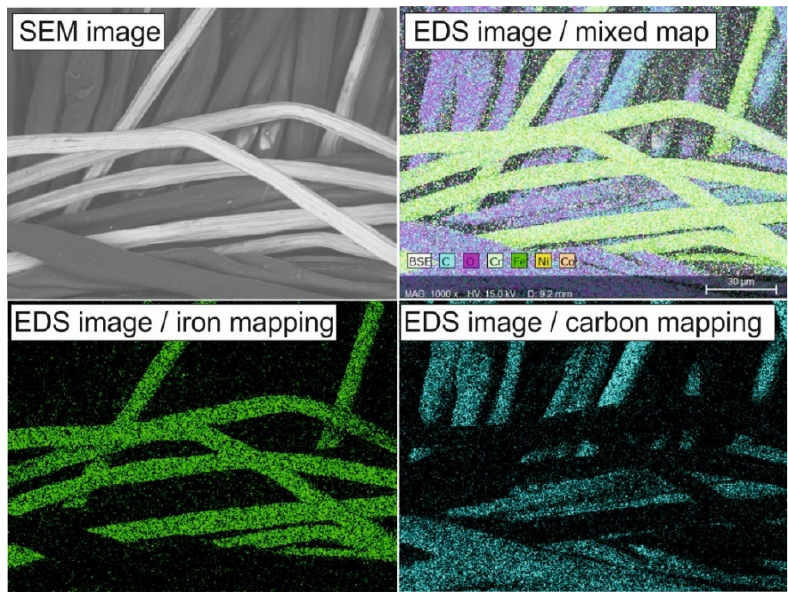
Figure 40. Presentation of a commercially available fabric containing steel fibers offered for the shielding of radio waves (electrosmog) (product from YShield, type Steel-Twin): ( a ) EDS spectrum of this fabric with detected chemical elements and their determined concentration; ( b ) SEM image.